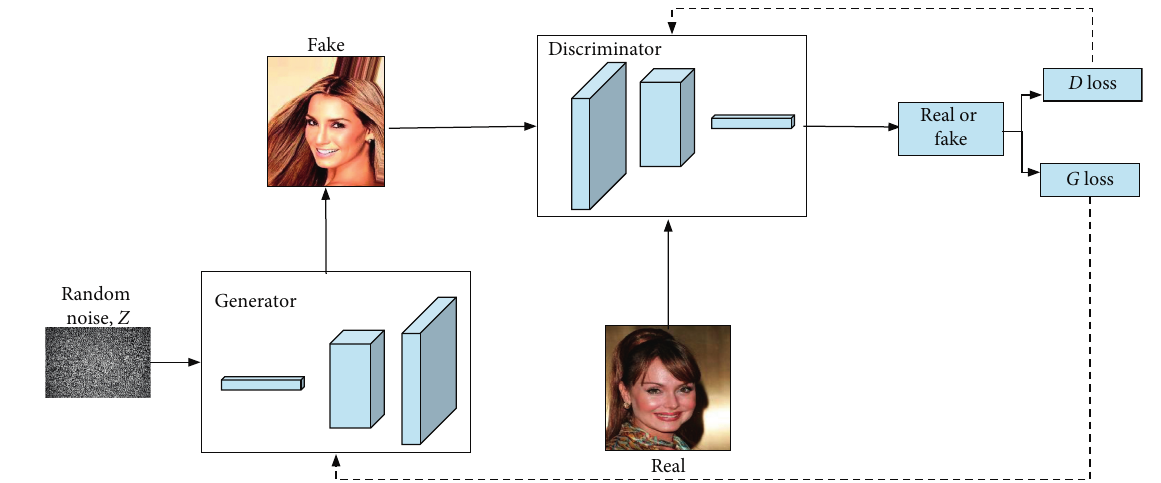
Figure 8: Deep generative adversarial network—human face generation.